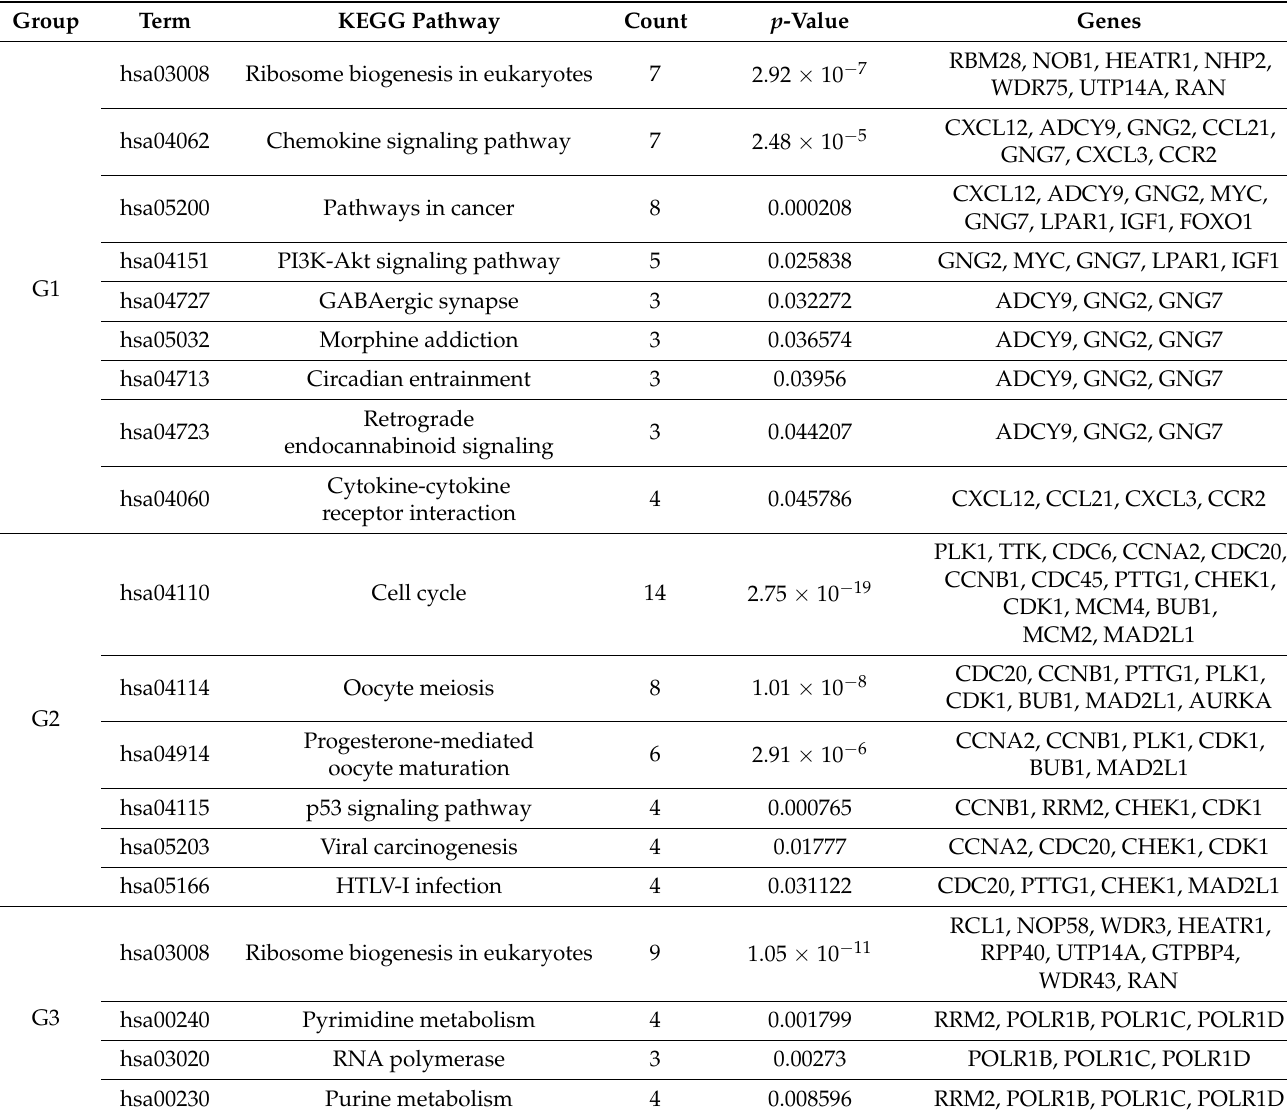
Table 4. KEGG Pathways related to hub